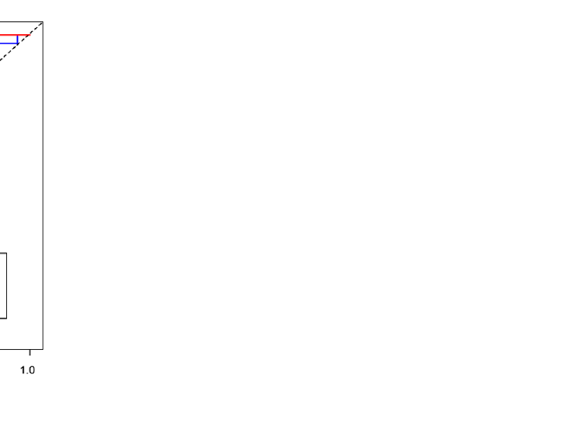
Figure 3. Correlation between serum carbohydrate-deficient transferrin and gammaglutamyl trans- ferase levels.